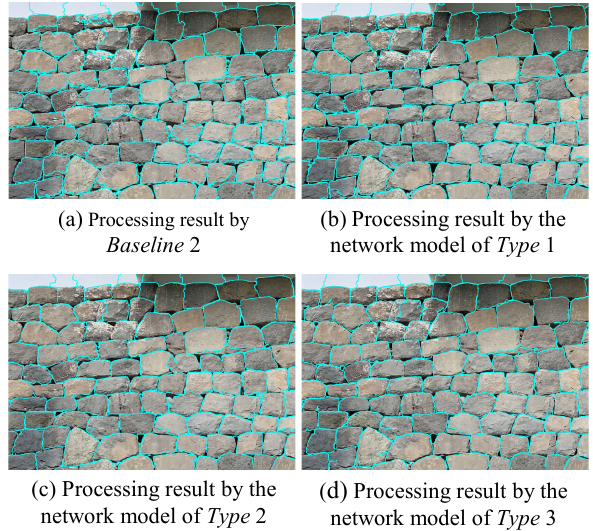
Figure 8. Comparison of wall stone polygon extraction after multiscale image